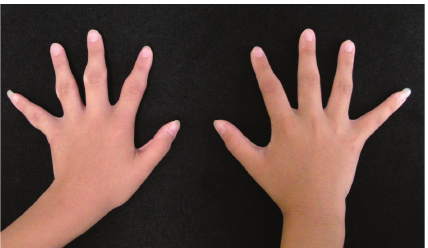
Figure 4: Photographic image of bilateral hands after treatment with tranilast. Improvement of symmetrical swelling around PIP joints after treatment with